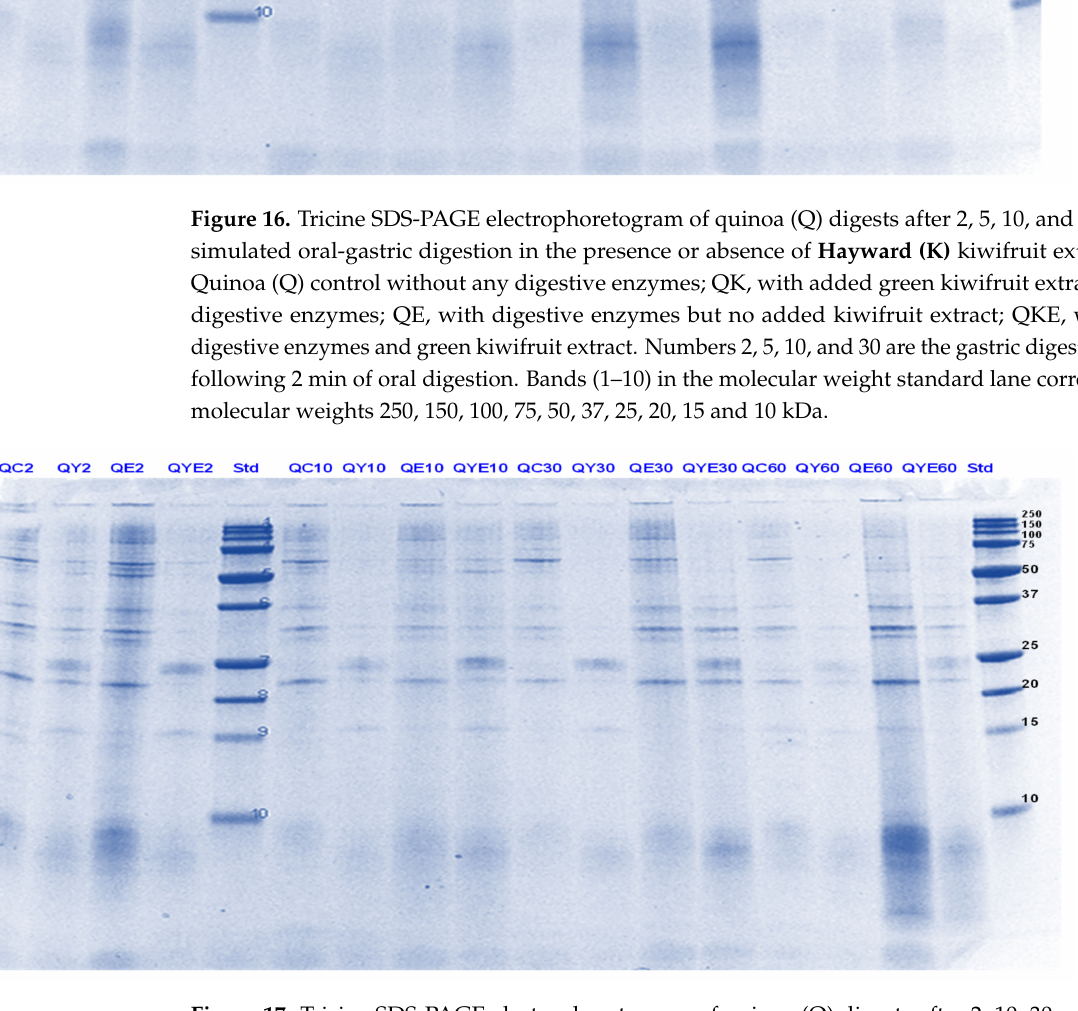
Figure 17. Tricine SDS-PAGE electrophoretogram of quinoa (Q) digests after 2, 10, 30 and 60 min of simulated oral-gastric digestion in the presence or absence of SunGold (Y) kiwifruit extract. QC, Quinoa (Q) control without any digestive enzymes; QY, with added gold kiwifruit extract but no digestive enzymes; QE, with digestive enzymes but no added kiwifruit extract; QKY, with both digestive enzymes and gold kiwifruit extract. Numbers 2, 10, 30 and 60 are the gastric digestion time following 2 min of oral digestion. Bands (1–10) in the molecular weight standard lane correspond to molecular weights 250, 150, 100, 75, 50, 37, 25, 20, 15 and 10